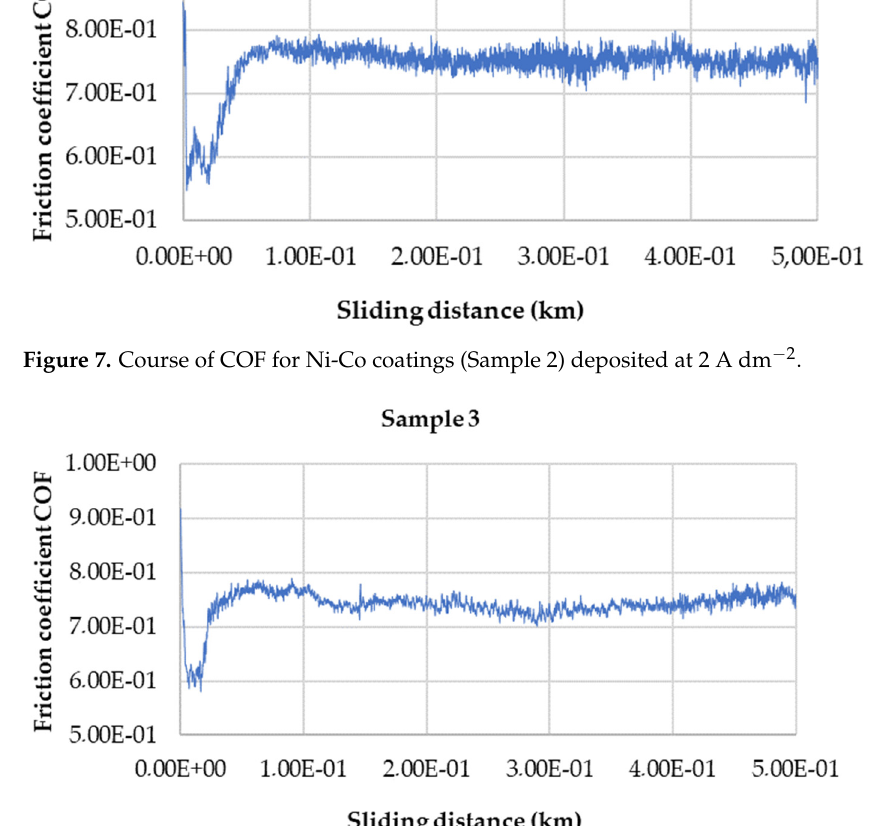
Figure 8. Course of COF for Ni-Co coatings (Sample 3) deposited at 4 A dm − 2 .